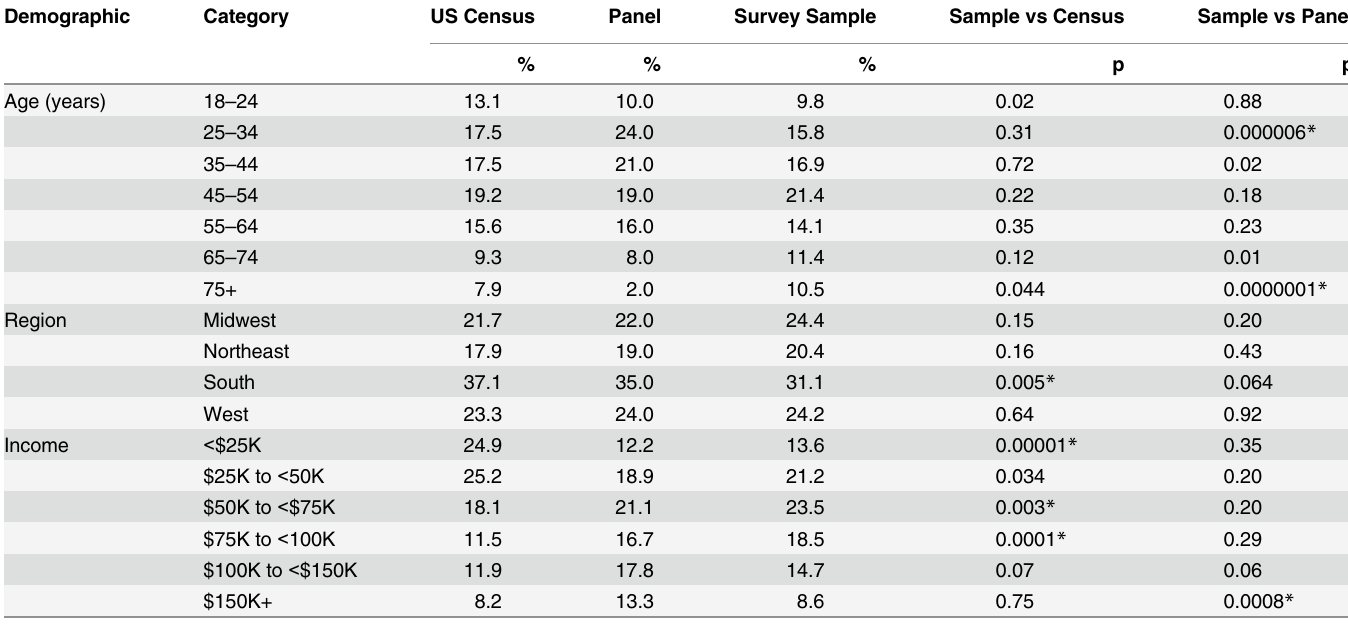
Table 1. Demographics: US Census (2010) and survey